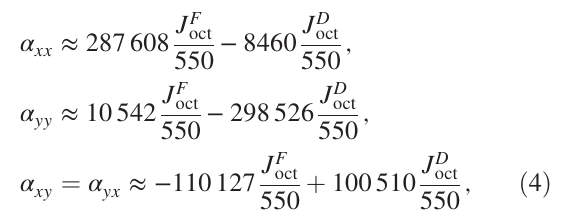
FIG. 1. MAD-X tracking results showing the tune footprint for different values of j C − j and constant tunes with J particle amplitude is extended to 4 σ . A clear impact on the tune spread can be observed as the coupling approaches the coupled tune separation. This severely inhibits the ability of the LOs to stabilize against a typical unstable mode (black